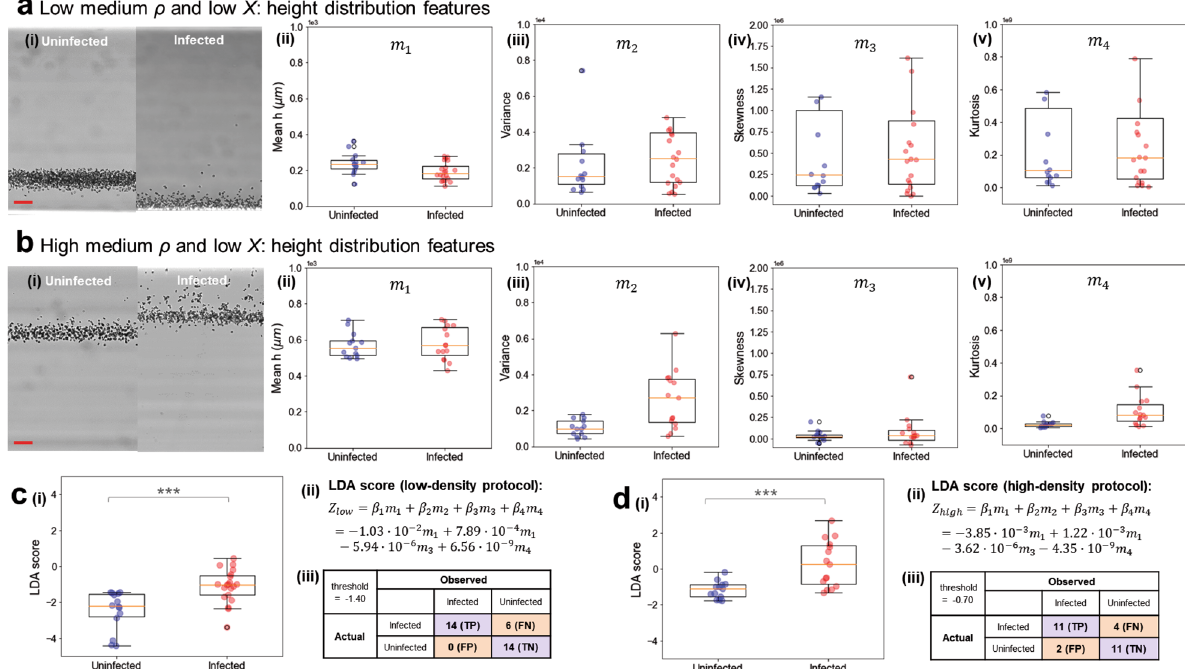
Fig. 4 Optimization of levitation medium conditions. a Uninfected blood cells and P. falciparum -infected blood cells (3D7 culture line, 5% parasitemia), levitated in isotonic low-density medium with optimized (low) magnetic susceptibility. (i) Example images of cells in levitation. Statistical parameters of the levitation height distribution for uninfected ( n = 14) and infected ( n = 20) samples: (ii) mean (m 1 ) ( (cid:129) 10 3 ), (iii) variance (m 2 ) ( (cid:129) 10 4 ), (iv) skewness (m 3 ) ( (cid:129) 10 6 ), and (v) kurtosis (m 4 ) ( (cid:129) 10 9 ). b Uninfected blood cells and P. falciparum -infected blood cells (3D7 culture line, ring-stage synchronized, 5% parasitemia), levitated in medium with optimized (low) magnetic susceptibility and optimized (high) density. (i) Example images of cells in levitation. Statistical parameters of the levitation height distribution for uninfected ( n = 13) and infected ( n = 15) samples: (ii) mean (m 1 ) ( (cid:129) 10 3 ), (iii) variance (m 2 ) ( (cid:129) 10 4 ), (iv) skewness (m 3 ) ( (cid:129) 10 6 ), and (v) kurtosis (m 4 ) ( (cid:129) 10 9 ). c (i) Linear discriminant analysis (LDA) scoring (Z low ) was performed on the statistical metrics (mean, variance, skewness, and kurtosis) for the samples levitated in a low-density medium, to classify them into healthy or infected groups. Box- and-whisker plots show the distribution of LDA scores for each sample tested. The scores for the two groups were statistically signi fi cant according to Welch ’ s t -test, with a p value of 8.5 × 10 − 4 . (ii) The resulting formula to calculate the LDA score as a recombination of the four metrics. (iii) A confusion matrix classifying each sample by its score, by applying a threshold of optimal separation ( − 1.40). d (i) Linear discriminant analysis (LDA) scoring (Z high ) was performed on the statistical metrics (mean, variance, skewness, and kurtosis) for the samples levitated in a high-density medium, to classify them into healthy or infected groups. Box-and-whisker plots show the distribution of LDA scores for each sample tested. The scores for the two groups were statistically signi fi cant according to Welch ’ s t -test, with a p value of 7.9 × 10 − 4 . (ii) The resulting formula to calculate the LDA score as a recombination of the four metrics. (iii) A confusion matrix classifying each sample by its score, by applying a threshold of optimal separation ( − 0.70). TP refers to true positive, FP to false positive, FN to false negative, and TN to true negative values. Box plots represent upper and lower quartiles, with the center line marking the median, and the whiskers showing the range of the data. (Scale bar 50 µ